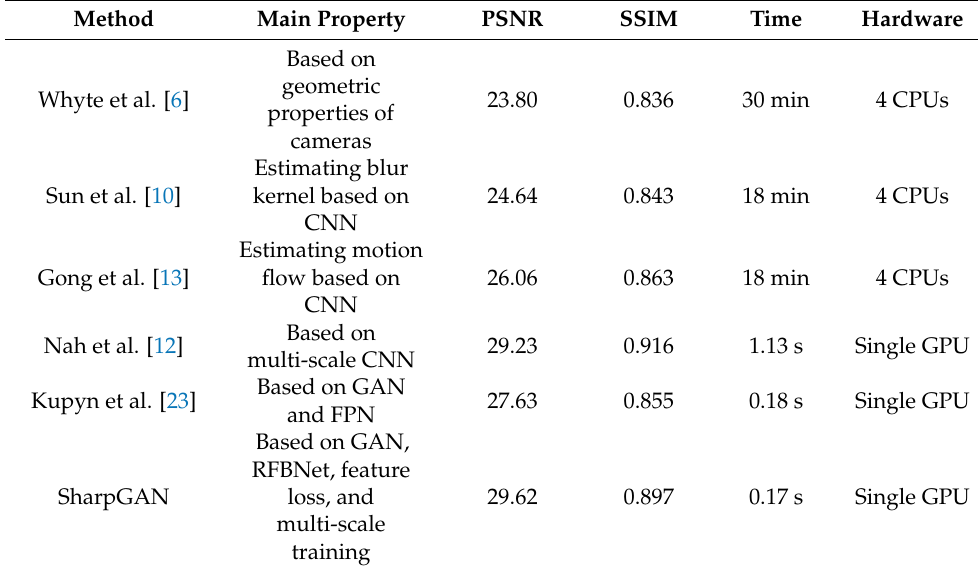
Table 2. The experimental results of different methods on the GOPRO